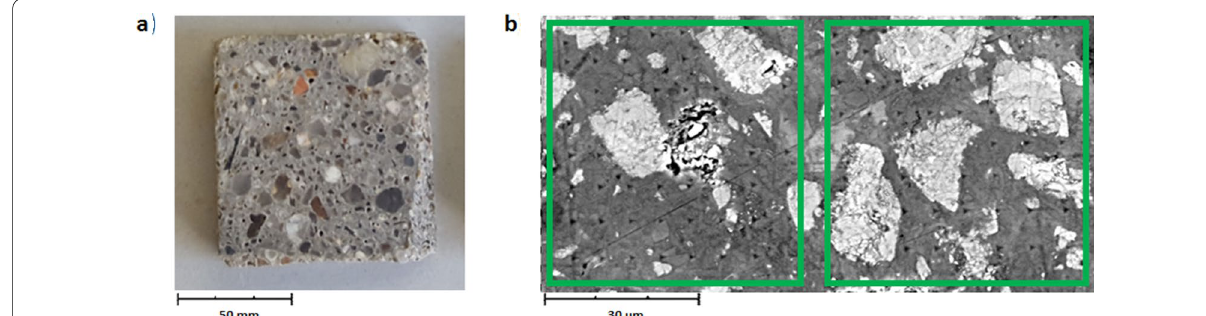
Fig. 5 Sample section used for nanoindentation: a sample surface, b SEM image with visible indents, where green squares indicate two individual